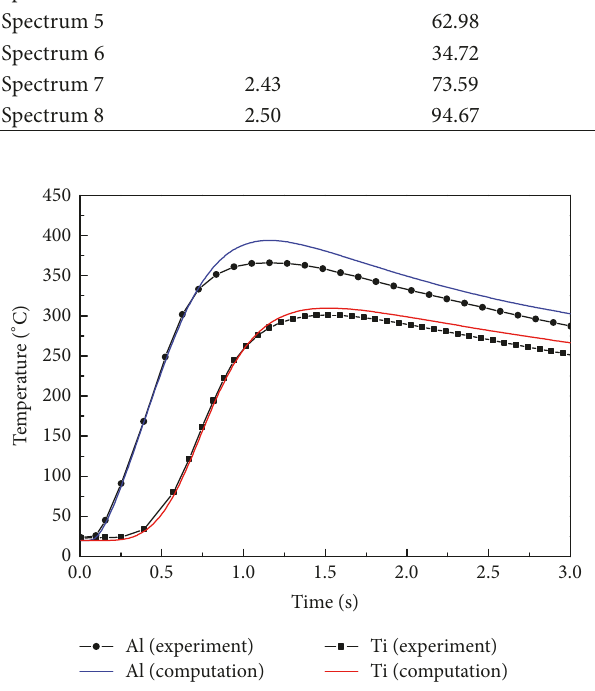
Figure 16: Time dependence of temperatures measured by thermo- couples and computed in the nodes corresponding to the location of thermocouples (laser power of 800 W; laser offset of 250 𝜇